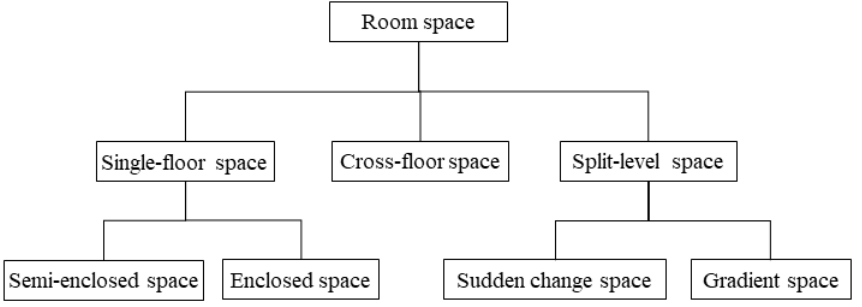
Figure 6. Classification of room space.